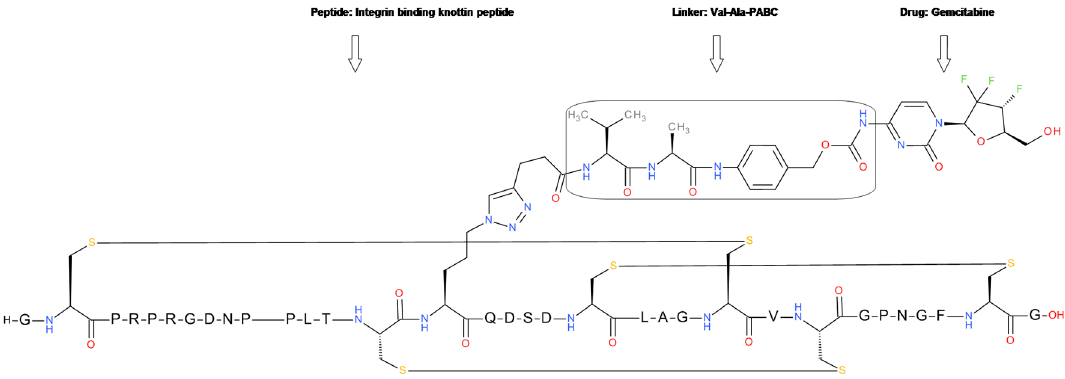
Figure 7. Chemical structure of knotting peptide ecballium elaterium trypsin inhibitor (EETI)-2.5Z-gemcitabine conjugate.